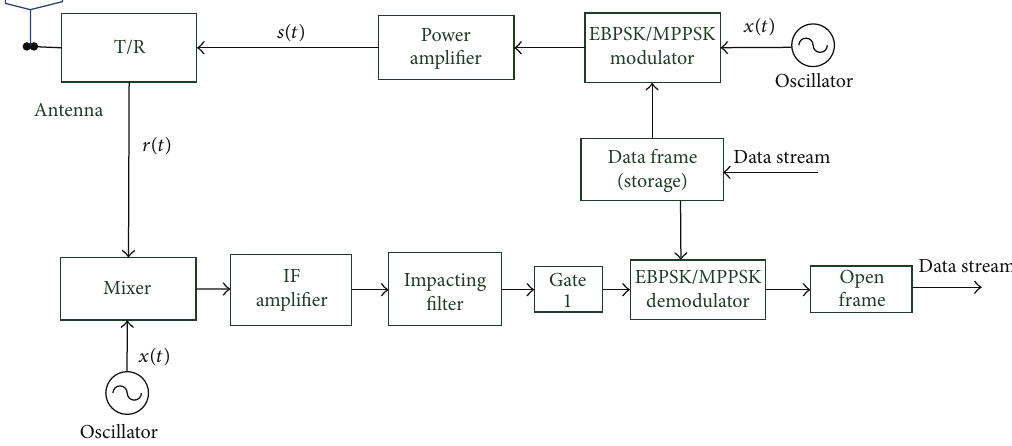
Figure 2: EBSPK-/MPPSK-modem based radar-communication